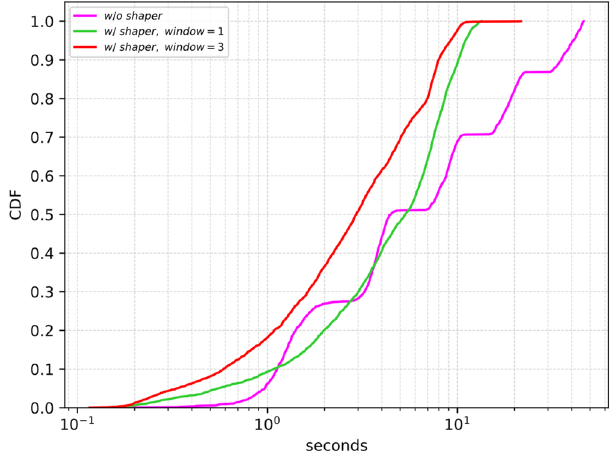
Figure 8. Service delay CDF for different values of the congestion window size, λ = 1/330 ms − 1 .